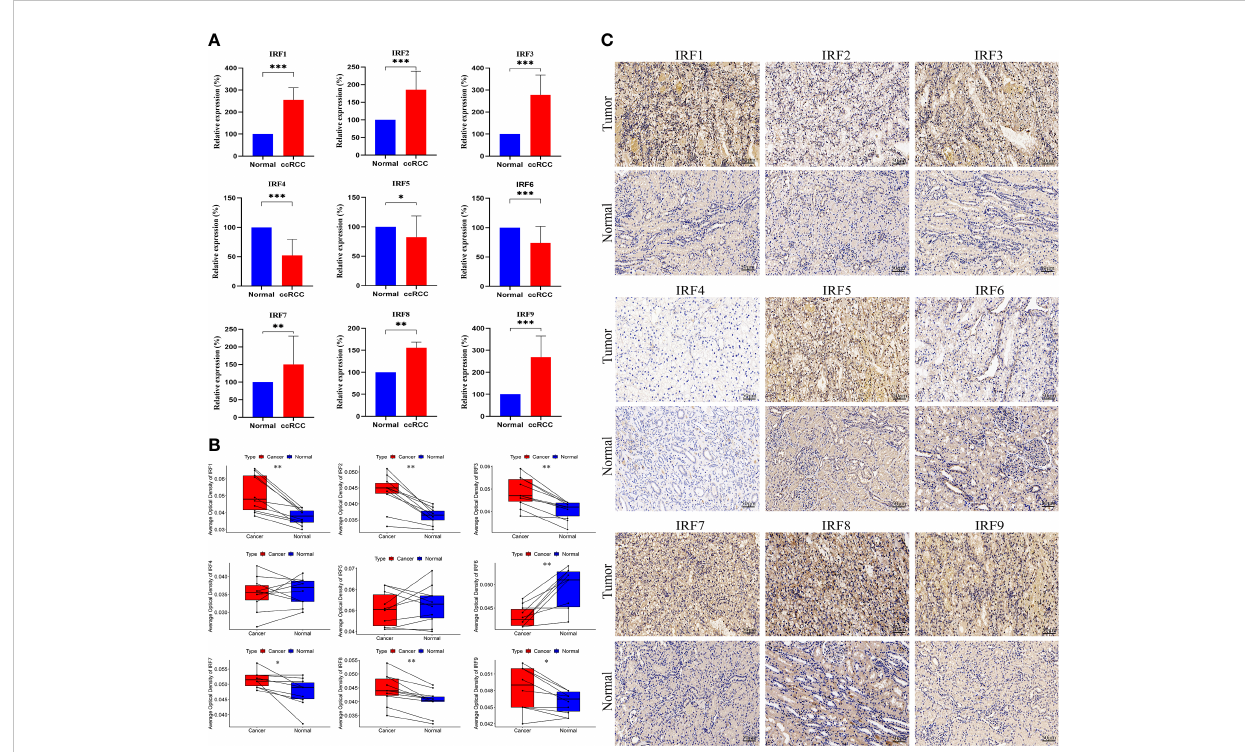
FIGURE 3 QRT-PCR and IHC analyses of the IRF family members. (A) The relative mRNA expression levels of the IRF family members between ccRCC and normal tissues were validated by qRT-PCR. (B) The AOD values of the IRF family members between ccRCC and normal tissues were compared. (C) Representative IHC staining of the IRF family members between ccRCC and normal tissues were shown. * p <0.05, ** p <0.01, *** p